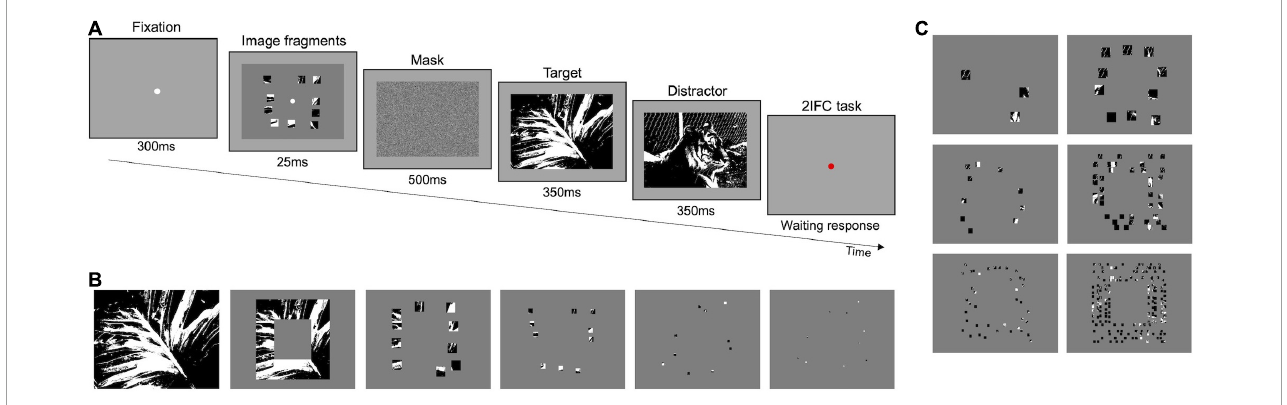
FIGURE1 Preliminary experiments–Procedure and stimuli. (A) Representation of experimental paradigm. (B) Examples of stimuli used in Preliminary experiment 1. The first image is the control stimulus, the second is the “frame” stimulus, and the others show 10 fragments of decreasing size (in order: 7.5, 2, 0.47, and 0.12%), positioned within the frame. (C) Examples of stimuli used in Preliminary experiment 2. In the left column, fragments revealed 2% of the image area, and in the right column, fragments revealed 7.5% of the image area. Fragments’ size in the images of each column decreases by fifty percent going from top to bottom; whereas fragments in the same row have the same size but vary in